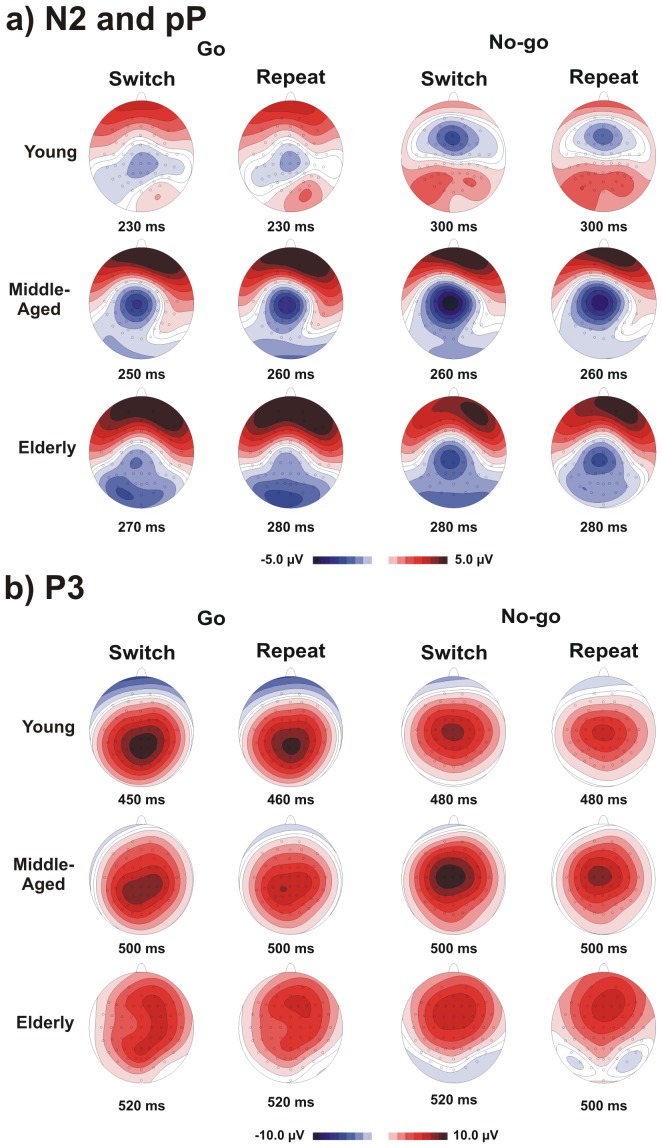
The scalp topographies for groups (young, middle-aged and elderly), Event Types (Go and No-go) and Response-Sets (Switch and Repeat conditions).The images represent activity on the scalp at the time corresponding to the maximal amplitude. Note the different time windows for the different age groups.